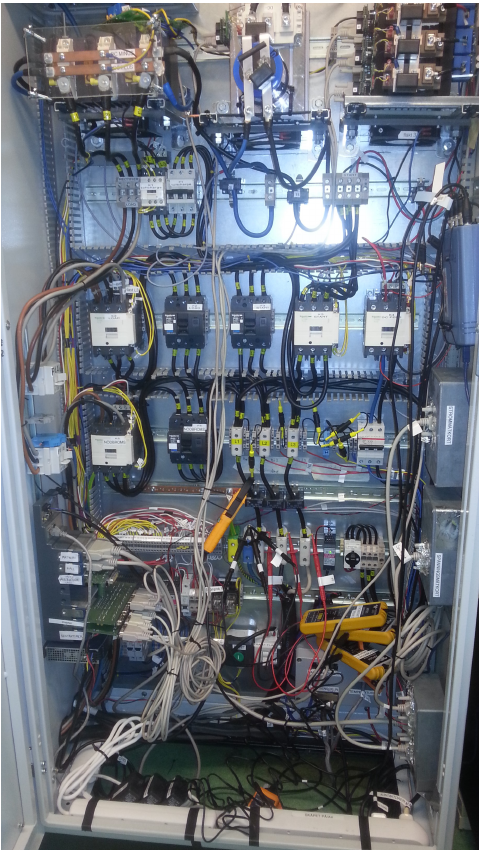
Figure 3. The electrical